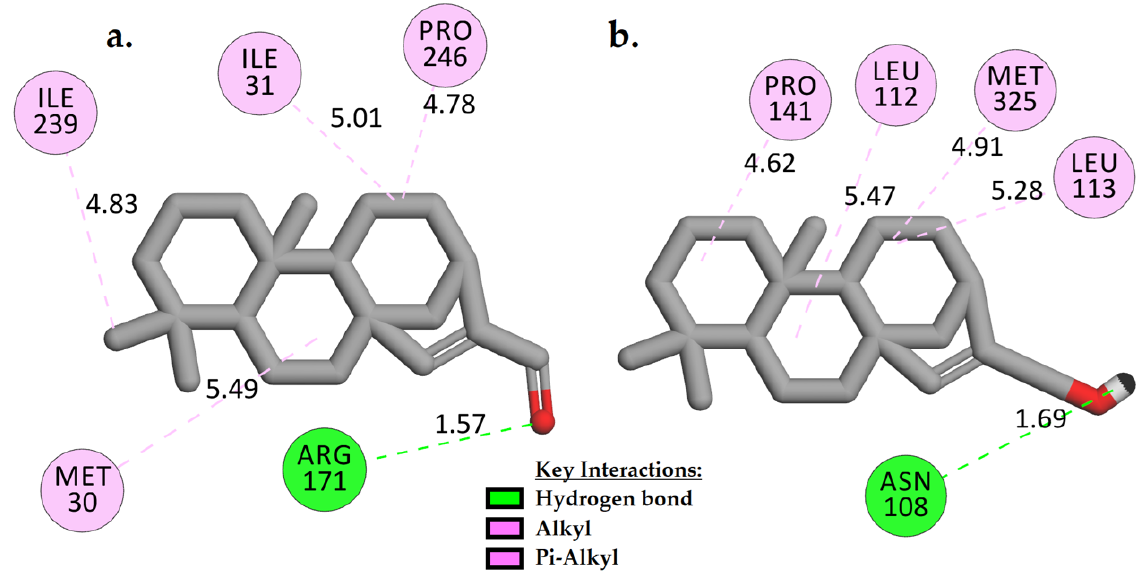
Figure 6. Two ‐ dimensional interaction models show how H ‐ bonds are formed between Pf LDH ‐ 1 ( a ) and Pf LDH ‐ 2 ( b ) with the amino acid residues in the Pf LDH active binding site at 100 ns (last snapshot) of MD time intervals.